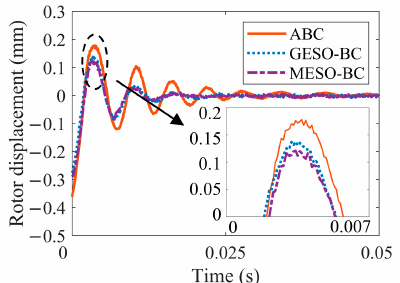
Figure 11. Floating performance experimental results.